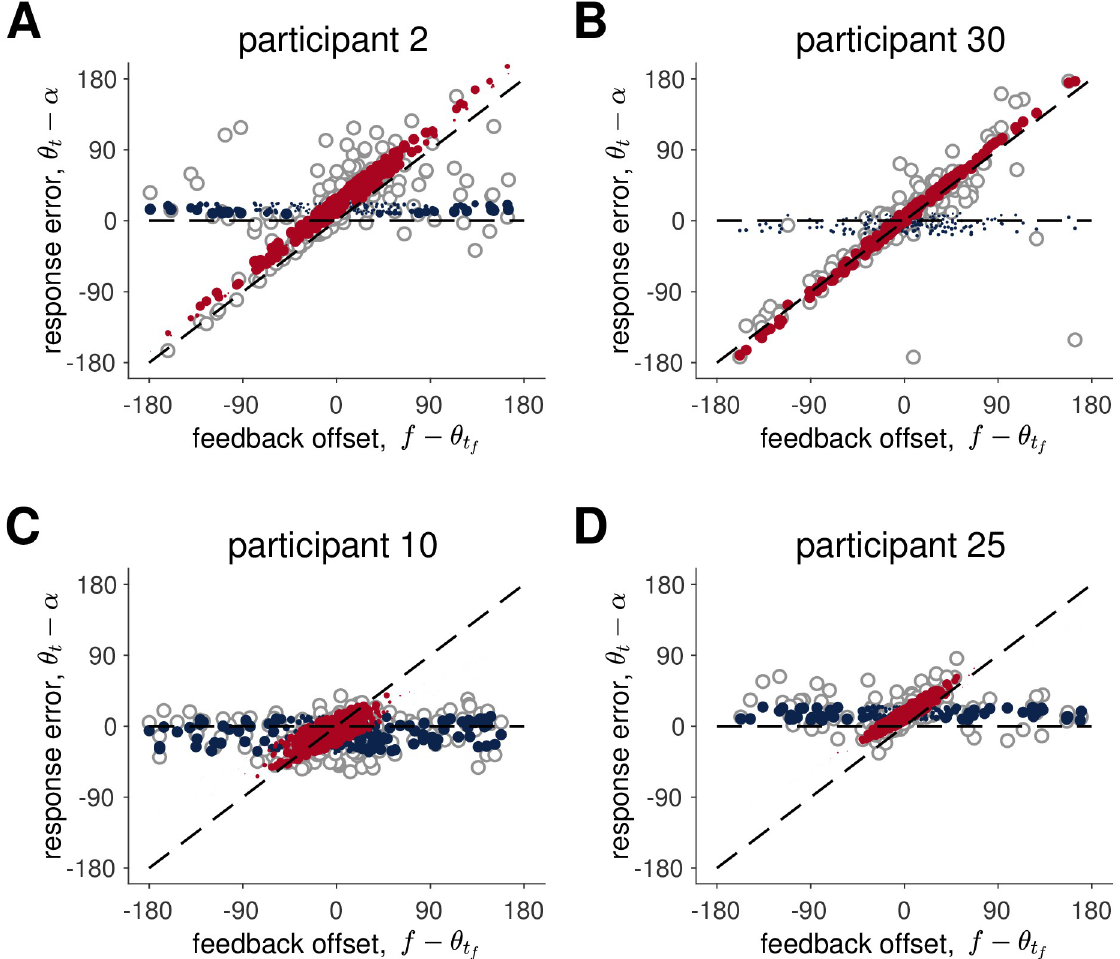
Fig 11. Comparison between data and the Hybrid model for four participants. Four participants’ data (open grey dots) are overlaid hybrid model’s mean responses when the model assumes the feedback is true (red) and false (blue). The size of the dots corresponds to the probability that the model samples from a distribution with this mean, i.e. p